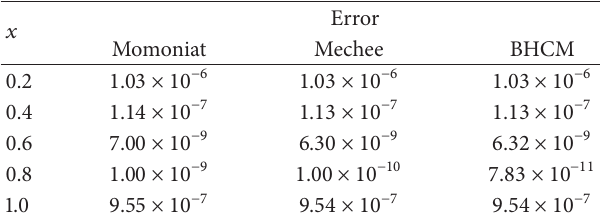
Table 6: Numerical results for problem in Thin Film Flow (29) with ℎ = 0.01, 𝑘 = 2 .